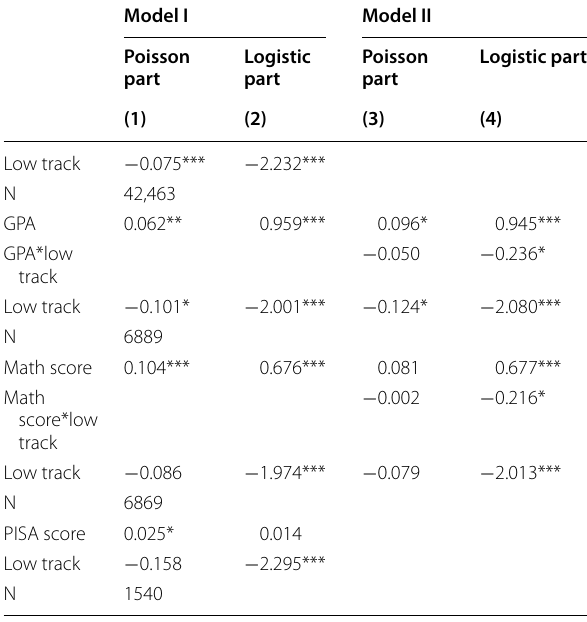
and grades on the accumulation of years of dual VET, selected